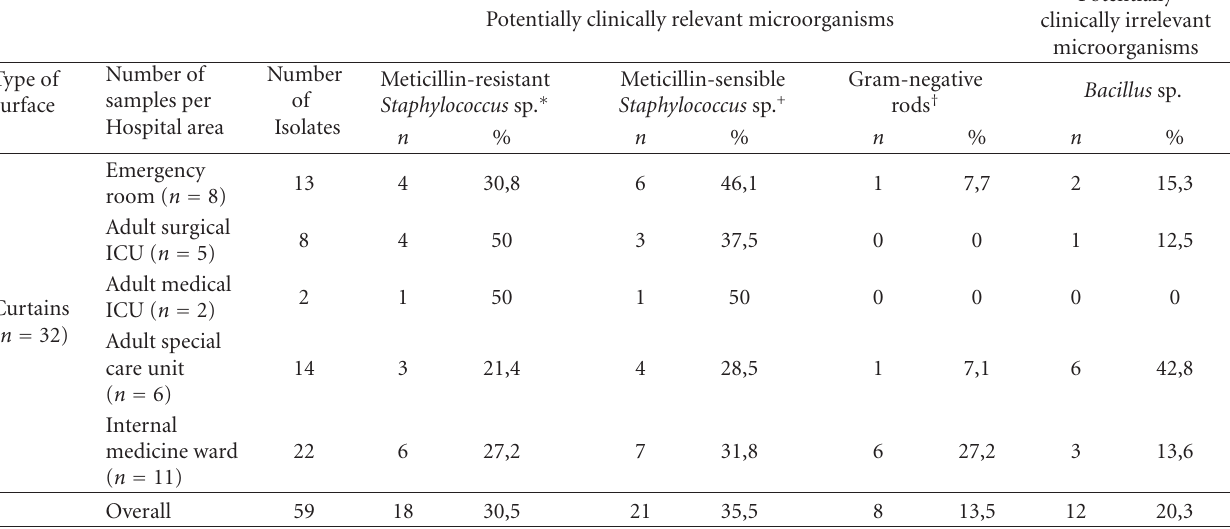
Table 2: Distribution of bacterial isolates from curtains. Potentially clinically relevant microorganisms